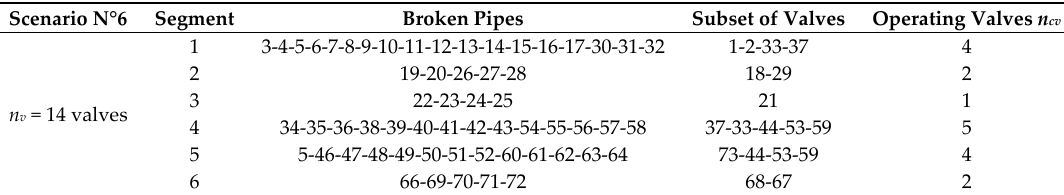
Table 2. Characteristics of the scenario n°6.